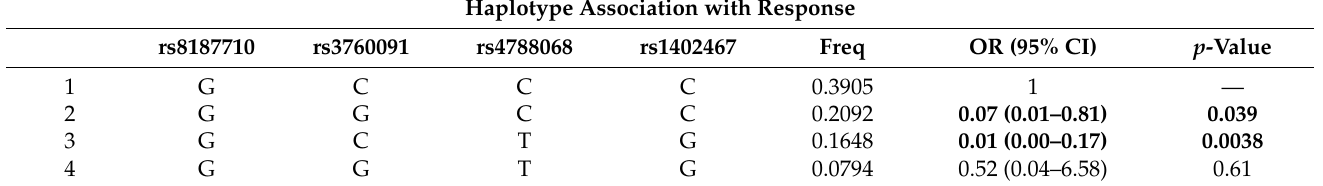
Table 12. Association between haplotypes of ABCC2_rs8187710/SULT1A1_rs3760091/SULT1A1_ rs4788068/SULT1C4_rs1402467 and the excretion of phase II flavanone metabolites in urine of studied volunteers after single dose of orange